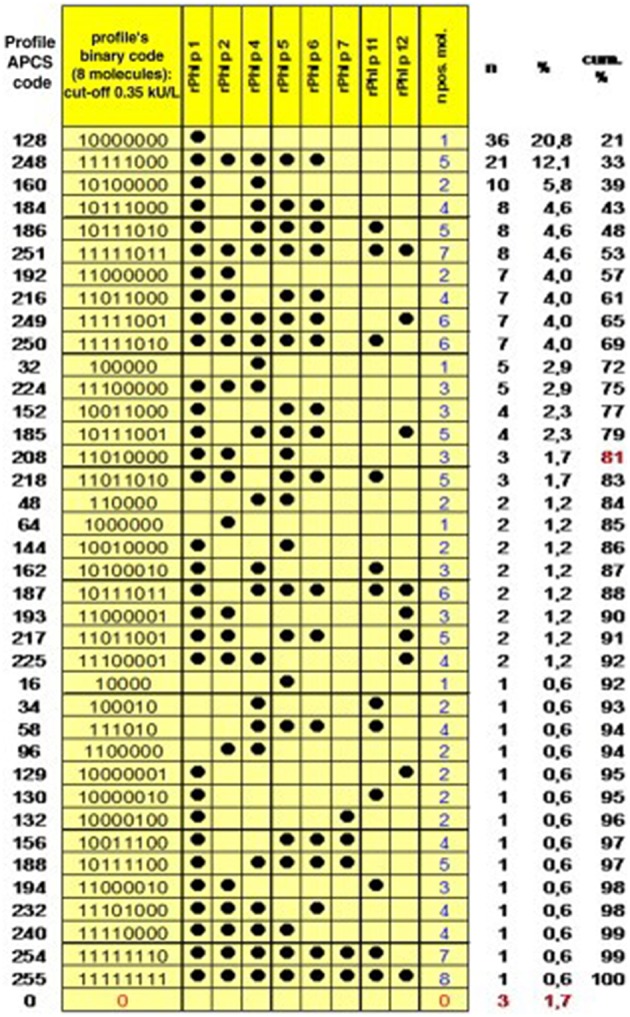
Profiles of IgE sensitization to 8 P pratense molecules in 176 children with an IgE reaction to P pratense and complete dataset. The Allergen Profile Codification System (APCS) code and the absolute and cumulative frequencies are shown. The profiles are ordered by decreasing frequency, and the point at which the arbitrary threshold of 80% of the patient population has been reached is marked in red [reprinted from (15), Copyright 2012, with permission from Elsevier].